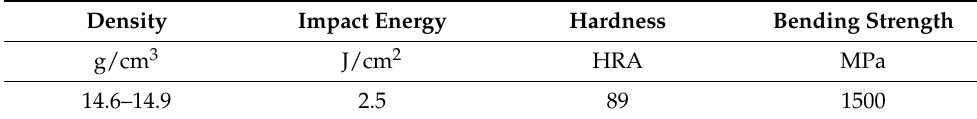
Table 1. Mechanical properties of the YG8.